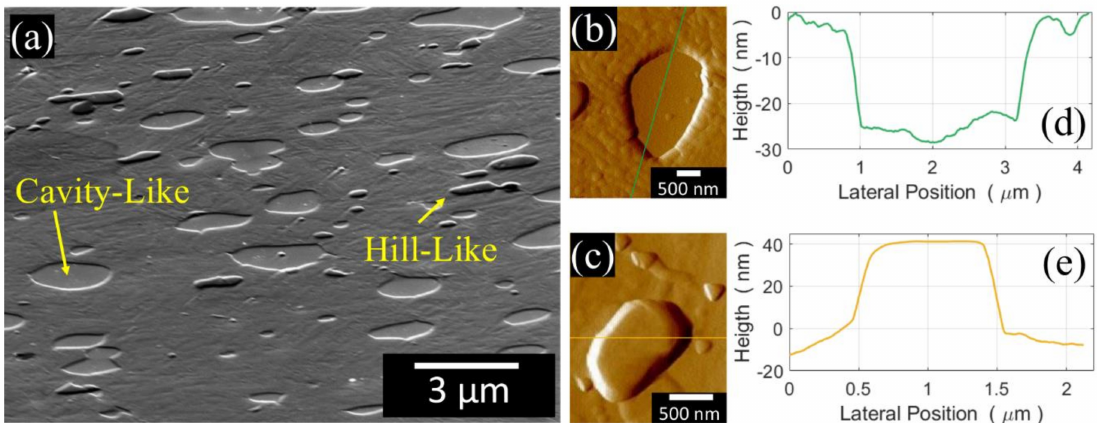
Figure 5. HSS base material after chemo-mechanical polishing. ( a ) Hill-like and cavity-like structures of MC and the M 6 C carbides in a cross-sectional view image obtained with a 20 ◦ tilted surface with respect to the FESEM electron beam; AFM force gradient in forward scanning mode of ( b ) an M 6 C cavity-like carbide and ( c ) MC hill-like carbides; topographical profiles of ( d ) an M 6 C cavity-like carbide and ( e ) MC hill-like